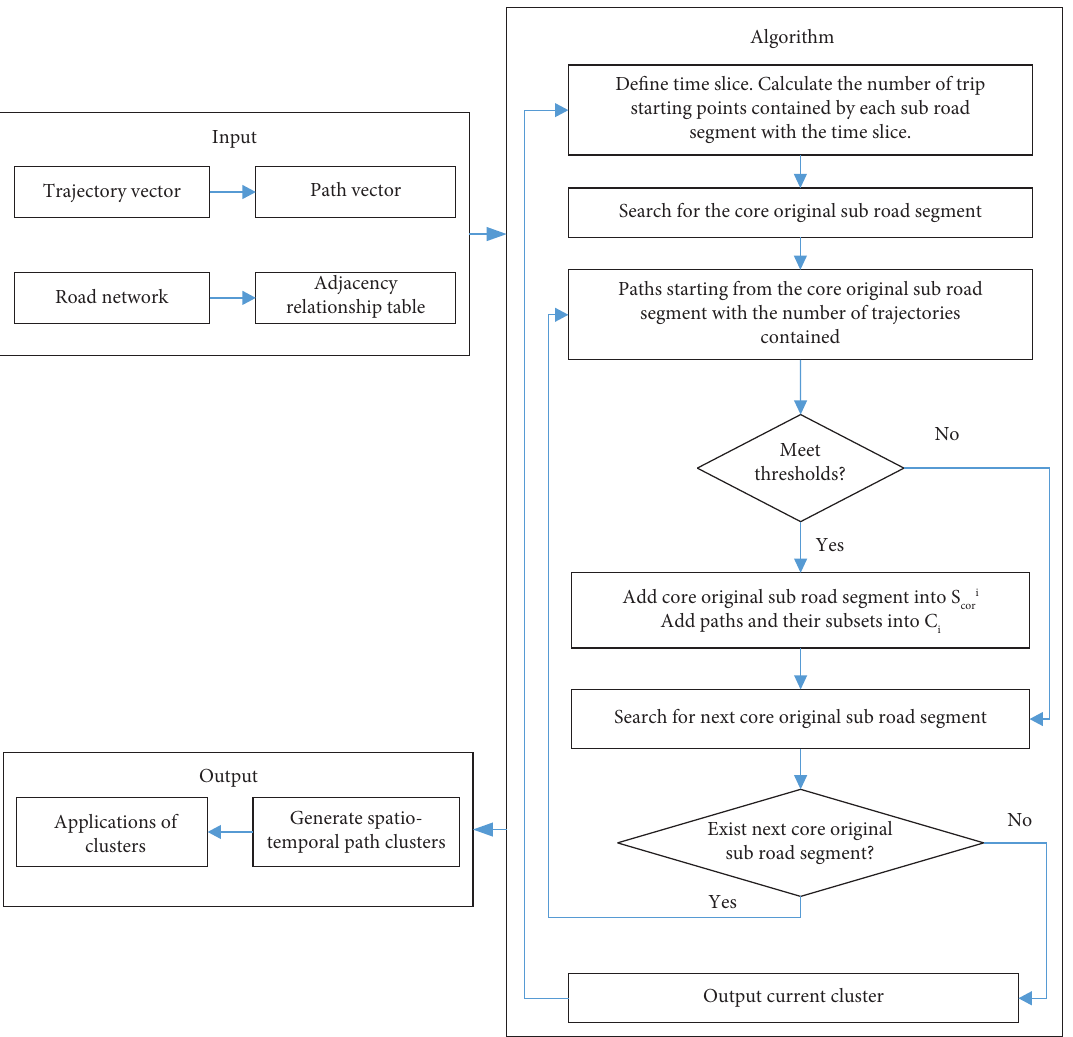
Figure 5: Flow chart of spatio-temporal path